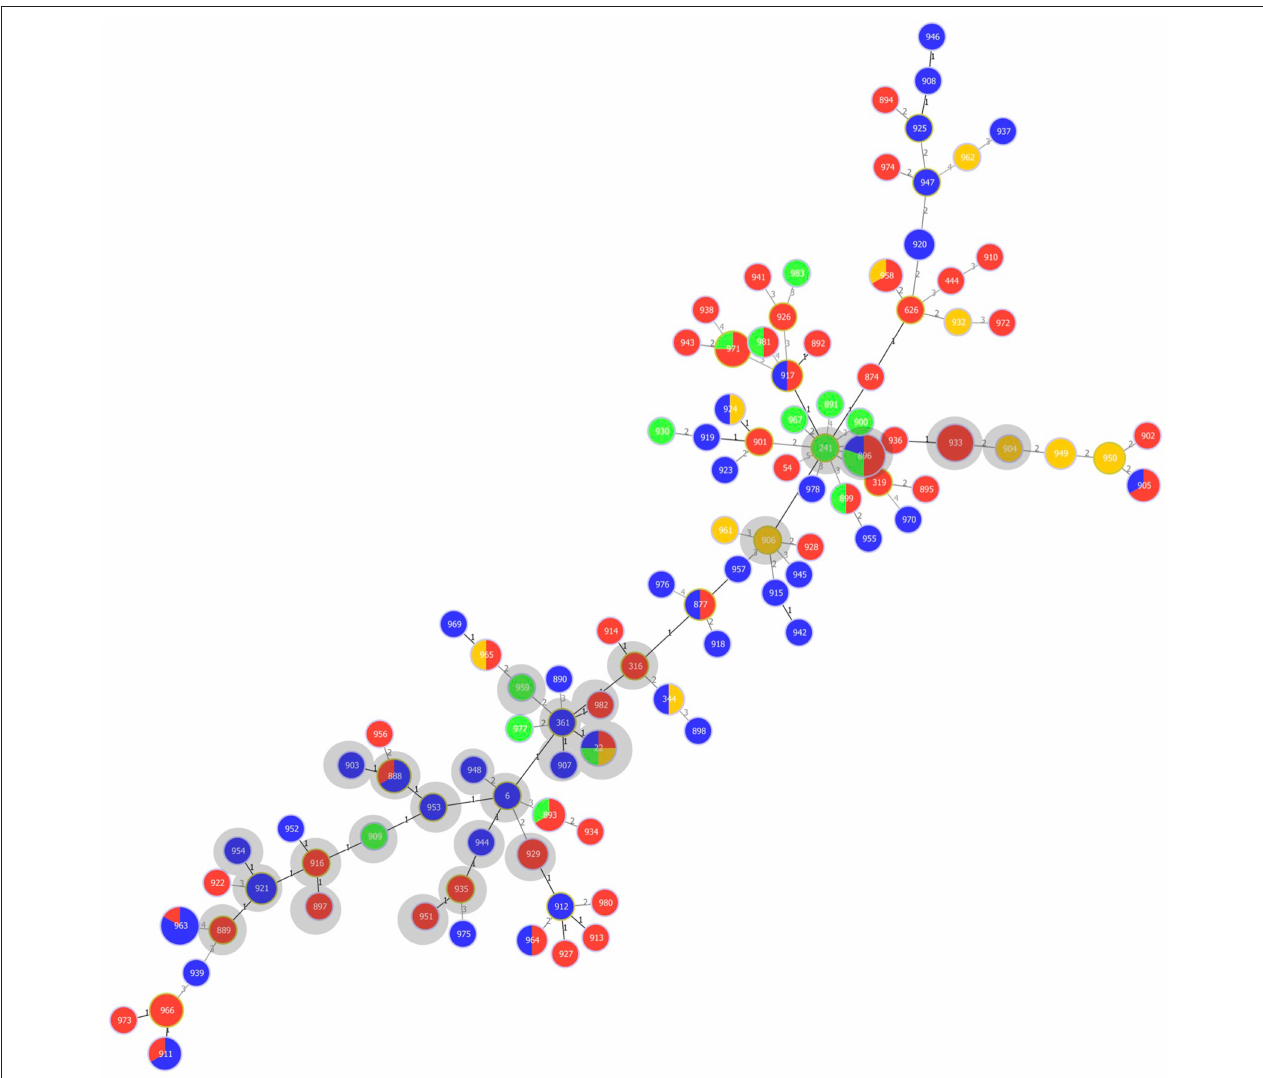
FIGURE 1 | Multilocus sequence type (MLST)-based minimal spanning tree of 152 Streptococcus uberis isolated from bovine mastitis milk during 2017 in Switzerland. The tree was calculated and generated using the goeBURST full MST algorithm in Phyloviz 2.0. Node sizes reflect the number of isolates with specific MLST profile. Numbers within the nodes indicate the ST. Node colors refer to types of mastitis: acute (red), subclinical (green), chronic (orange), unspecified mastitis (blue). Numbers on lines indicate locus variants between adjacent nodes. Grey shadows indicate STs belonging to clonal complex